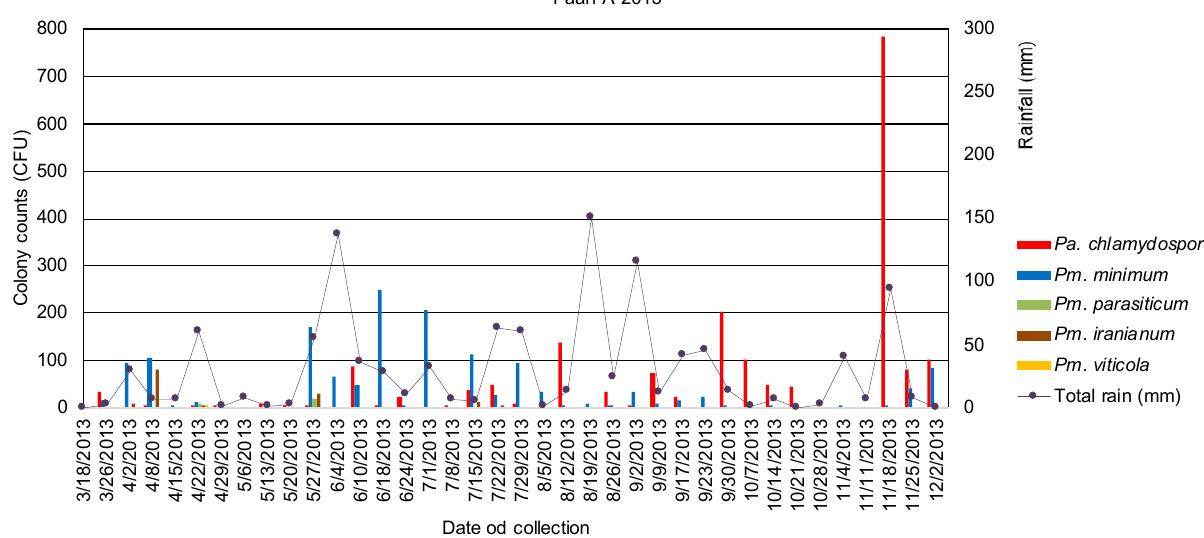
Figure 2. Phaeomoniella and Phaeoacremonium spp. cfu cultured from five vaseline coated microscope slides affixed to the cordons on each of five vines in vineyard Paarl A, Western Cape province in 2013. The slides were replaced weekly. Each bar represents the total number of cfu cultured on three Petri dishes. Not clear on the graph, Pm. viticola detection date is 22/04.